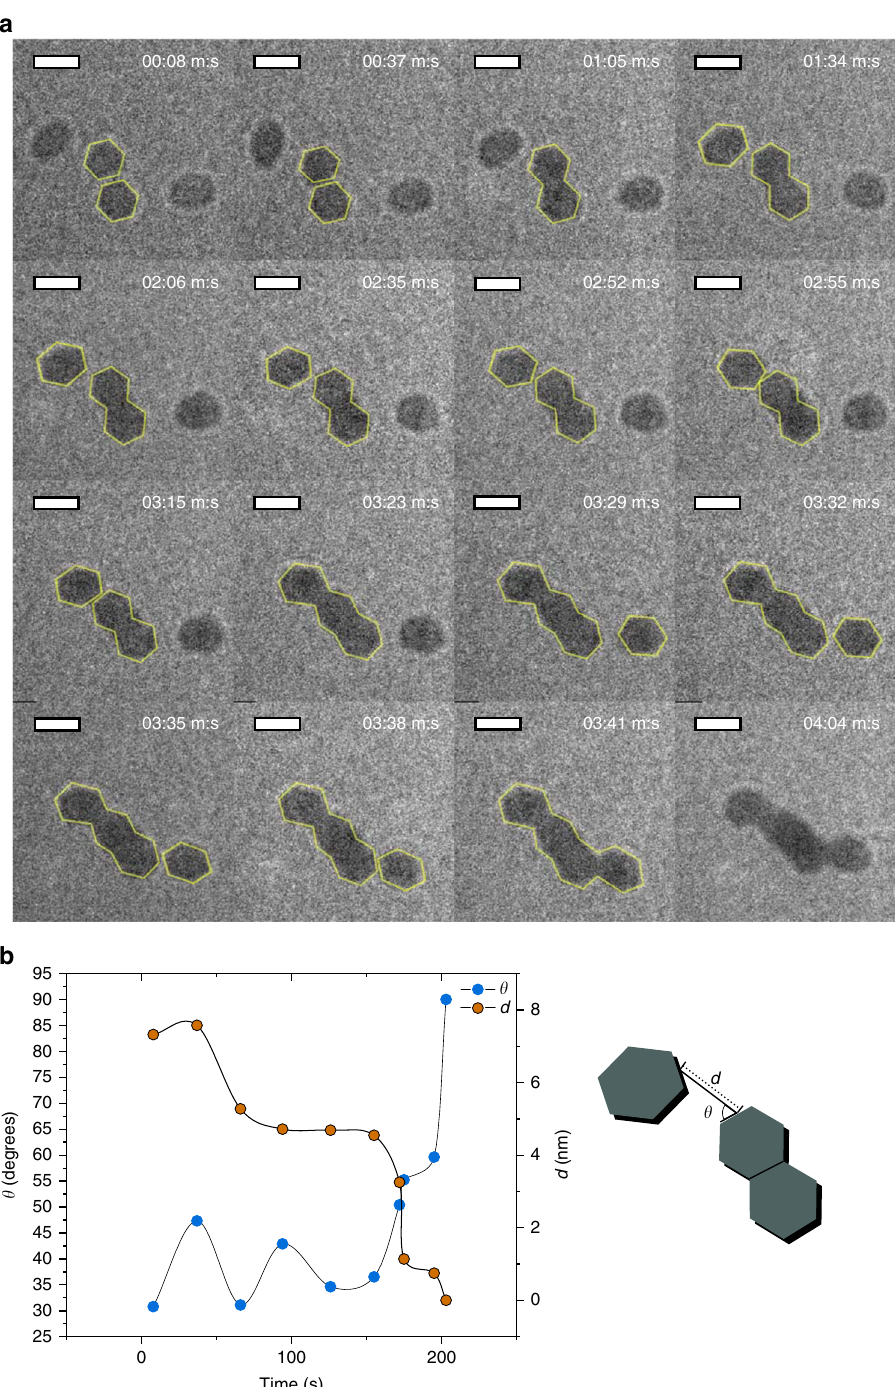
Fig. 4 Oriented attachment of LDH nanoparticles, observed via LTEM. a LTEM frames showing the oriented aggregation of hexagonal particles (outlined). Scale bar is 10 nm. b Left, the angular orientation θ and distance d between facets of attachment for the aggregation event observed from 1:34 to 3:23 (m:s), where lines are added to guide the eye. Right, a schematic showing measurements of θ and